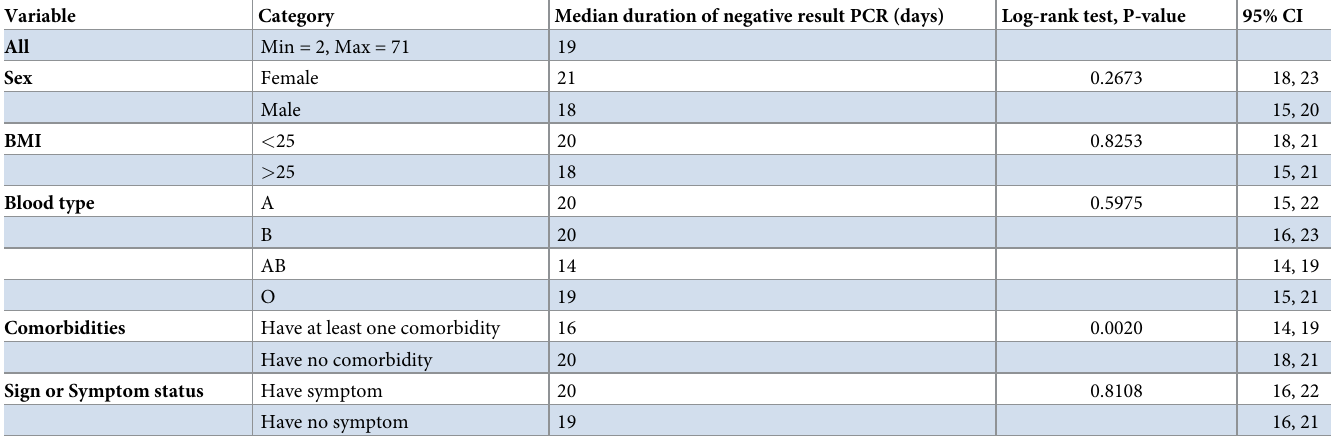
Table 2. Duration of viral clearance by different factors: Eka Kotebe General Hospital, COVID-19 Isolation and Treatment Center, 2020. Variable